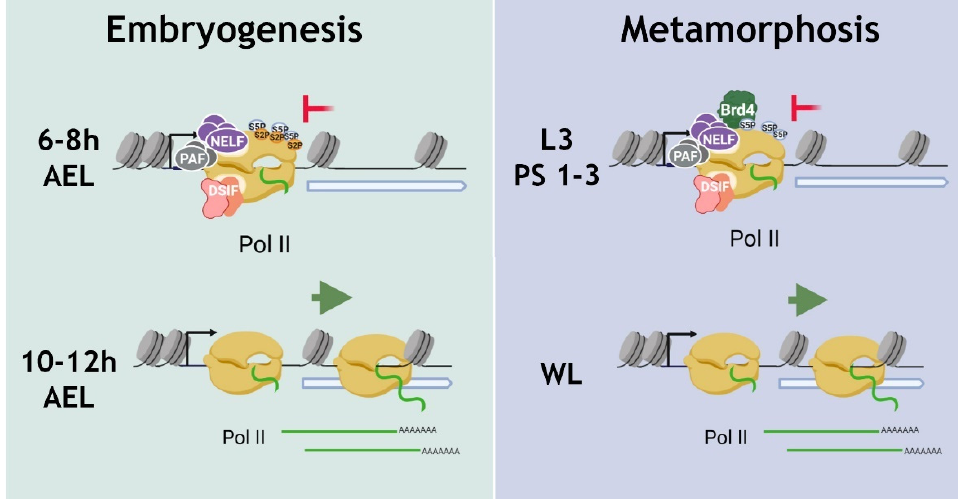
Figure 9. Schematic model describing specific features of RNA polymerase II “pause” complexes that prepare Drosophila genes induced at 10–12 h AEL of embryogenesis and during L3 PS7-9 empty gut stage of the metamorphosis (in wandering larvae: WL) for upcoming transcription during em- bryogenesis and metamorphosis. The “pause” of RNA polymerase II which prepares “10–12 h genes” for the induction during mid-embryogenesis is characterized by phosphorylation of its Pol II CTD not only by Ser5 but also by Ser2. The embryonic “pause” complex contains NELF, DSIF, and PAF complexes but lacks Brd4/Fs(1)h due to the low expression level of this protein at this stage of development. During metamorphosis, the genes, induced in wandering larvae (WL) use pro- moter-proximal pausing, which is characterized by a high level of Pol II CTD Ser5P and a low degree of Pol II CTD Ser2 phosphorylation. The “pause” complex contains NELF, DSIF, and PAF complexes and Brd4/Fs(1)h protein. The figure was drawn by the authors using biorender.com software (ac- cessed on 10 August 2022).